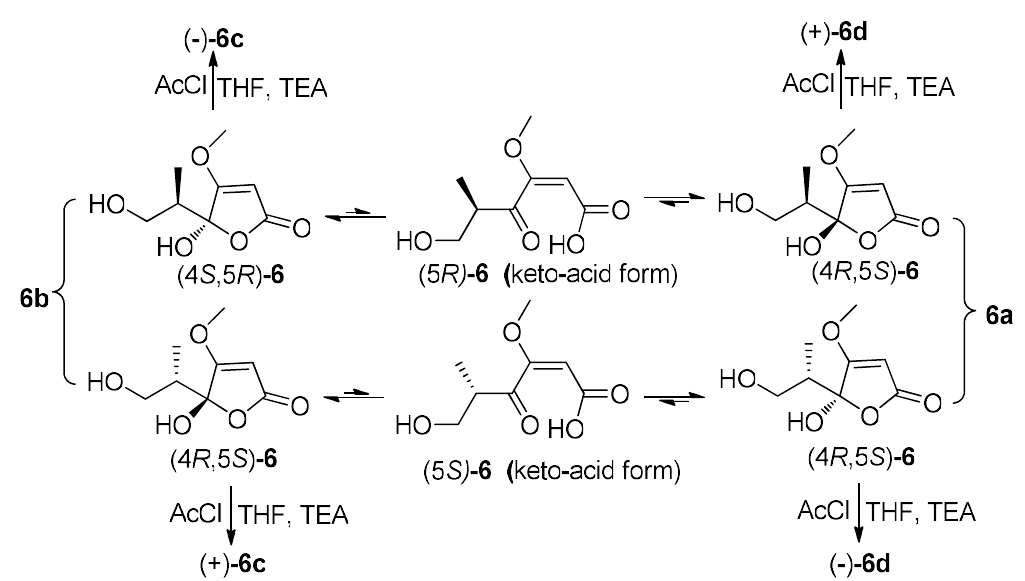
Figure 4. Tautomeric forms ( γ -keto-acids and γ -hydroxyl butenolides) of 6 , and the reaction of 6 with AcCl.